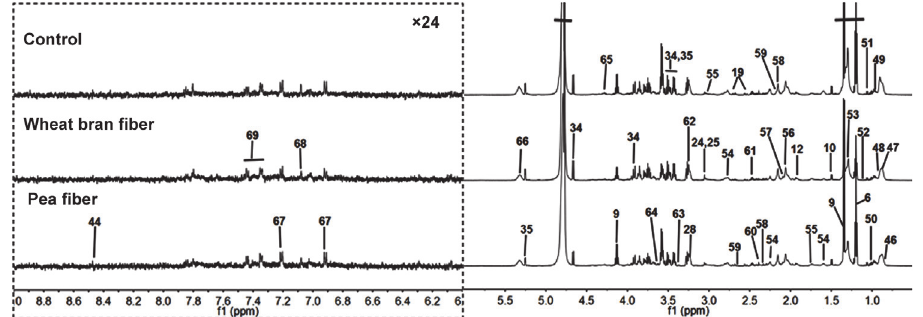
Fig 1. Representative one-dimensional 1 H NMR spectra urine metabolites obtained from the (A) control, (B) pea fiber, and (C) wheat bran fiber groups. The region of δ 6.2 – 9.5 was magnified 16 times compared with corresponding region of δ 0.5 – 6.2 for the purpose of clarity. Metabolite keys are given in Table 5.